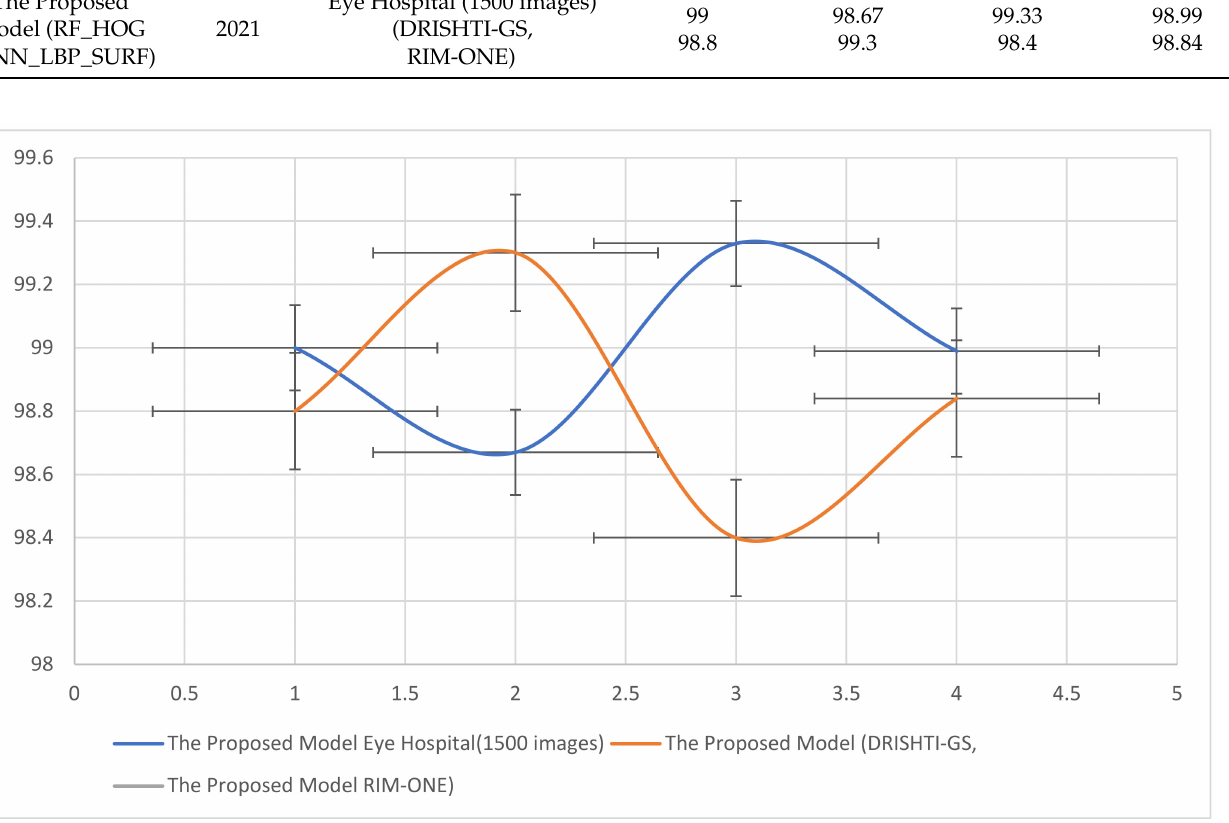
Figure 9. Accuracy, Recall, Precision and F1 Score of the proposed algorithm according to